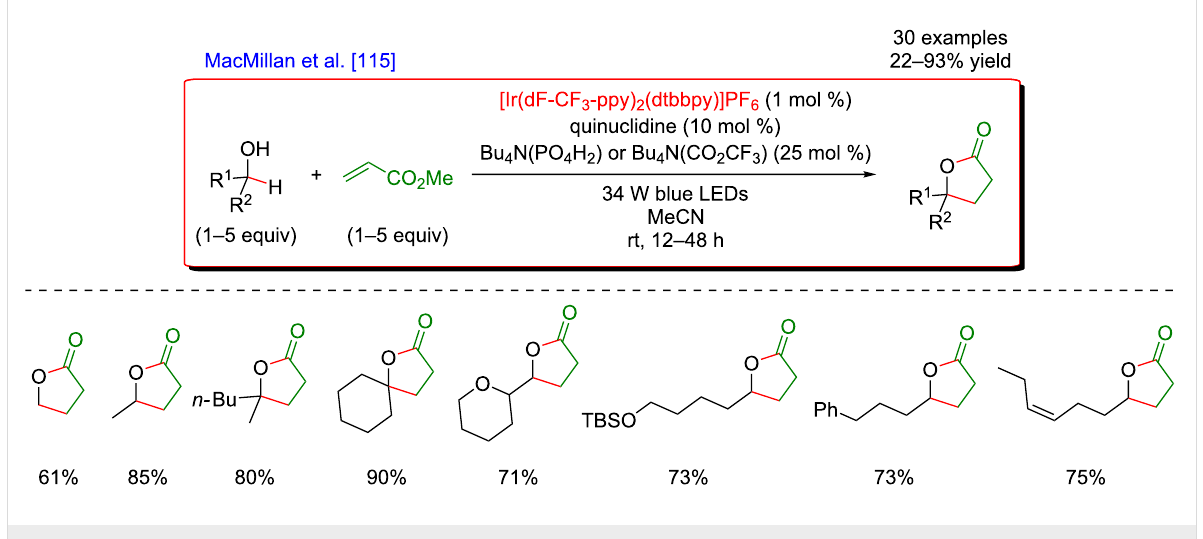
Figure 54: C–H Alkylation of alcohols promoted by H-atom transfer (HAT).